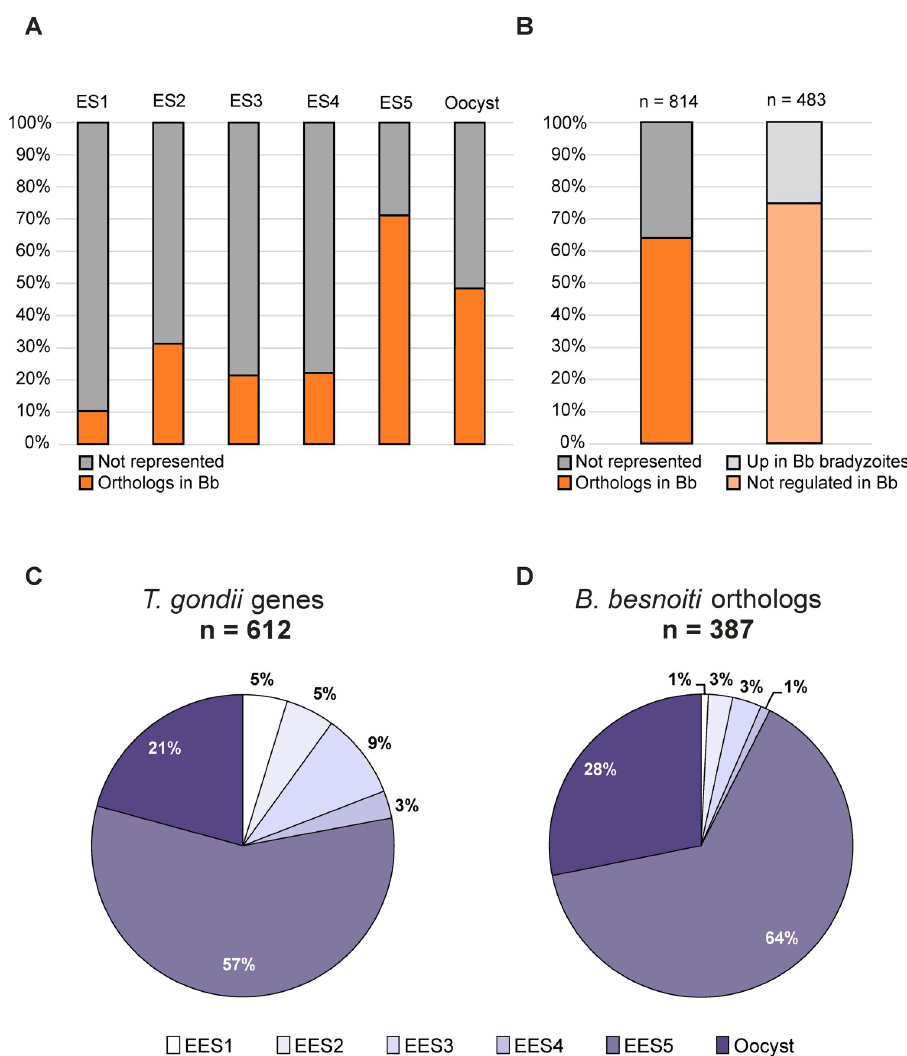
Fig 10. B . besnoiti orthologues involved in sexual reproduction and oocyst formation. (A) Bar chart showing the percentage of B . besnoiti orthologues identified for all T . gondii genes with expression maxima EES1-5 or oocysts (oocyst genes listed as in [38]). (B) Percentage of B . besnoiti genes (LFC > |2|) identified that are orthologous to upregulated genes in T. gondii tissue cysts (n = 814) (left graph) [38] This results in 483 unique B . besnoiti genes of which approximately 75% are not differentially regulated between tachyzoites and tissue cysts (right graph). (C) Percentage of T . gondii genes having expression maxima in a distinct coccidian stage. (D) As in (C), but for B . besnoiti